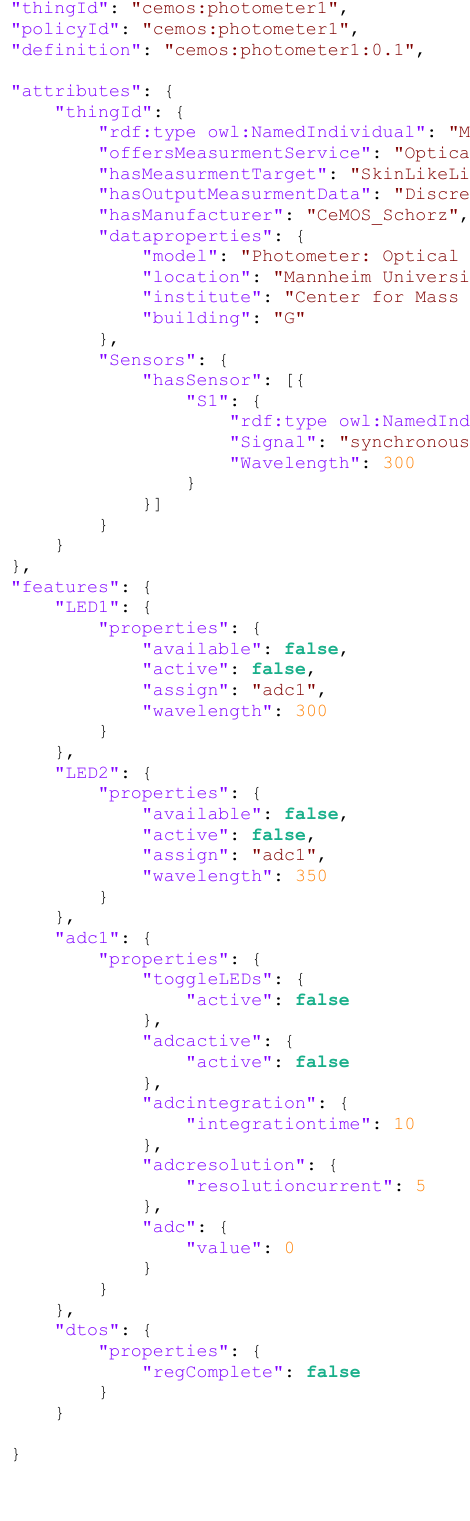
Figure A1. Eclipse Ditto Information